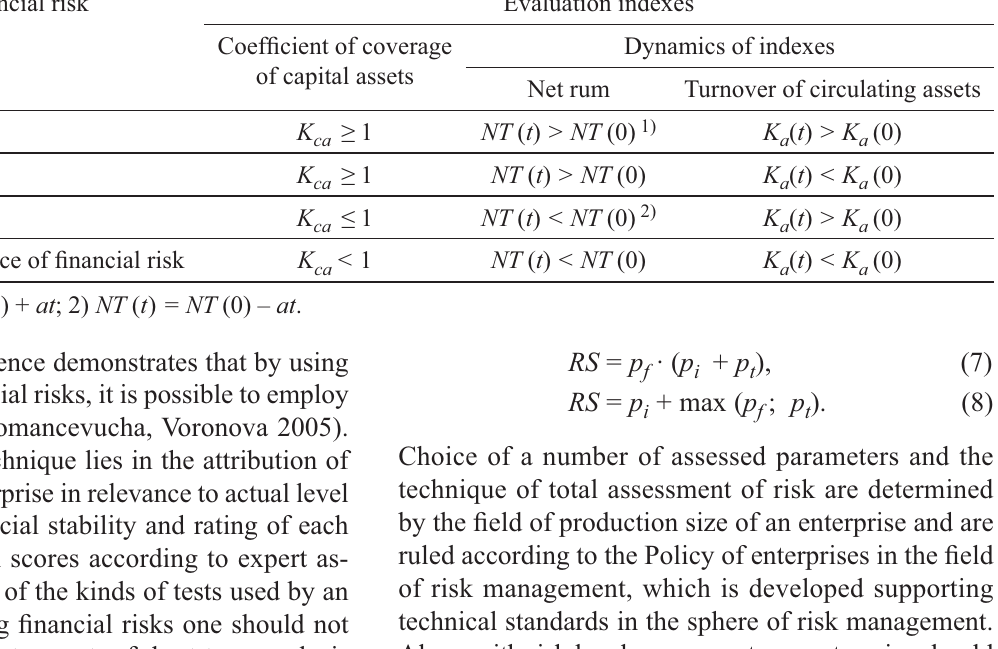
Table 6. Determination of level of fi nancial risk of enterprise, being at the maturity stage Level of fi nancial